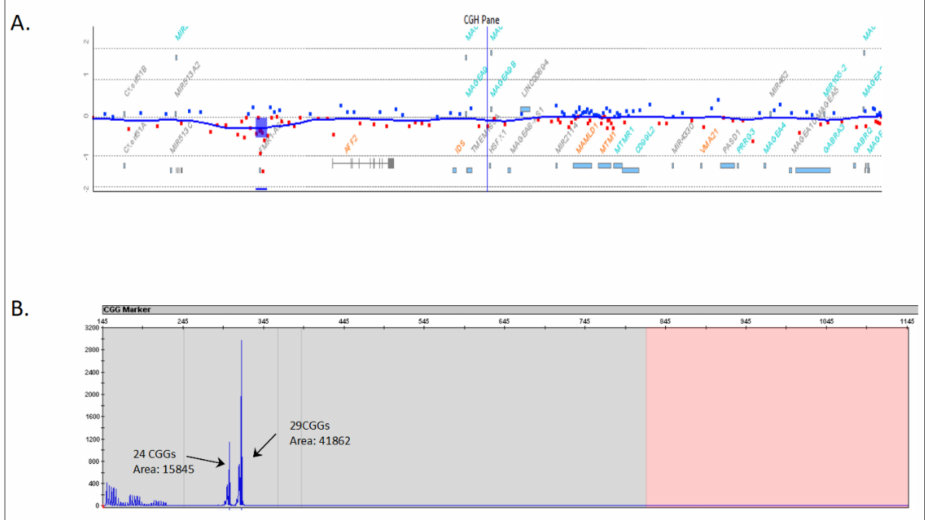
Figure 3. Genetic analysis of the mother (index case). ( A ) FMR1 gene deletion detected by means of a chromosomal microarray. ( B ) Validation of the FMR1 gene deletion mosaicism by means of an AmplideX ® FMR1 PCR assay. CGG repeat size and area of the peaks are indicated next to each